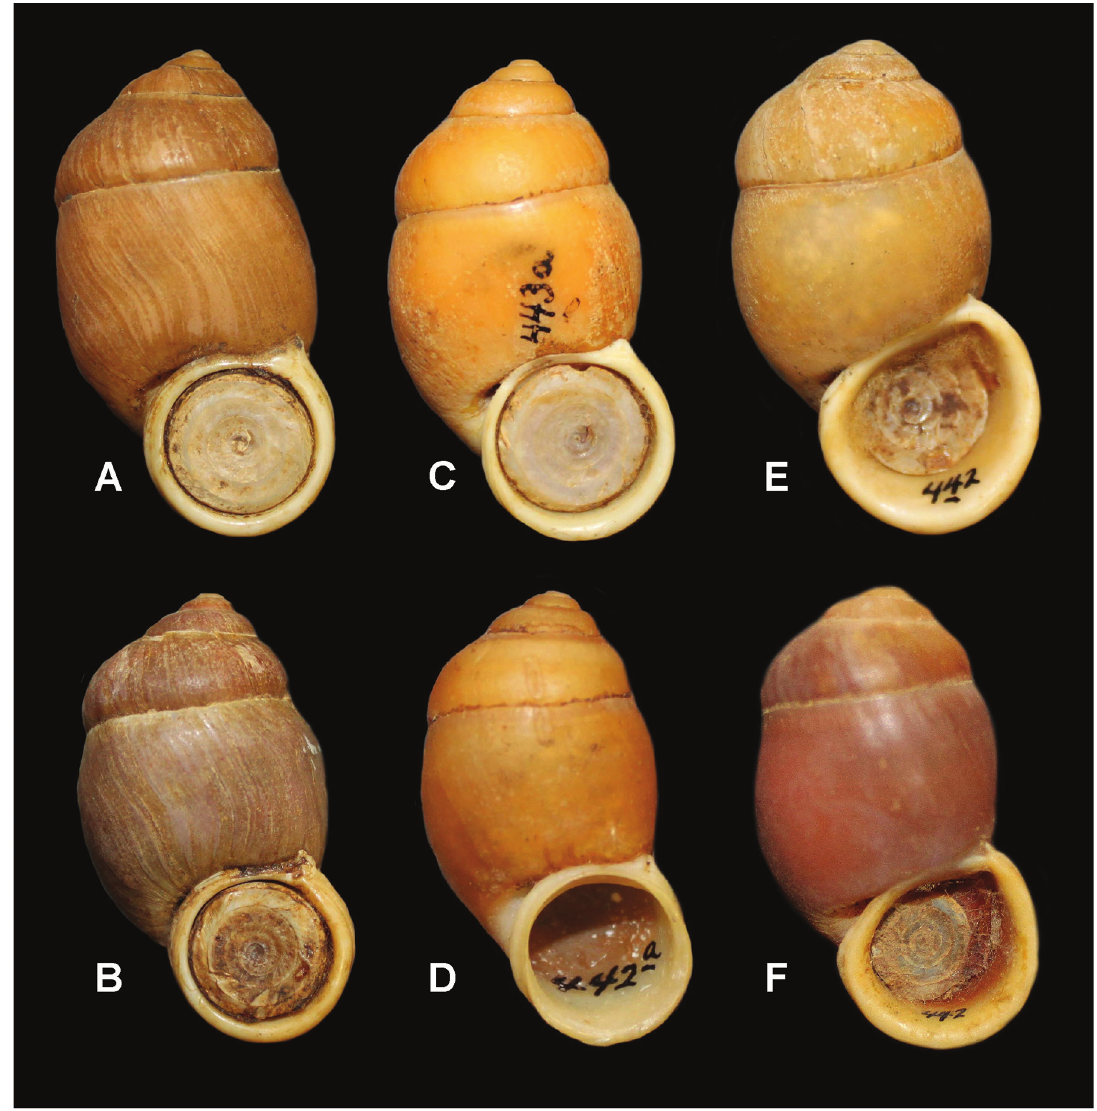
Figure 2. Vietnamese Pollicaria from museum collections. A and B . FLMNH 130267, Pollicaria rochebruni , Tonkin Province, 36.9 mm and 34.4 mm respectively. C . FLMNH 164622 (in part), P. cf. crossei sensu Kongim et al. (2013), Thất Khê, Tonkin Prov - ince. 28.5 mm. Labeled as P. rochebruni . D . FLMNH 164621 (in part), P. cf. crossei sensu Kongim et al. (2013), Pak-Kha, Tonkin Province, 24.6 mm. Labeled as P. mouhoti . E and F . FLMNH 164620, P. mouhoti , Gia Phu, Tonkin Province, 32.5 mm and 30.9 mm